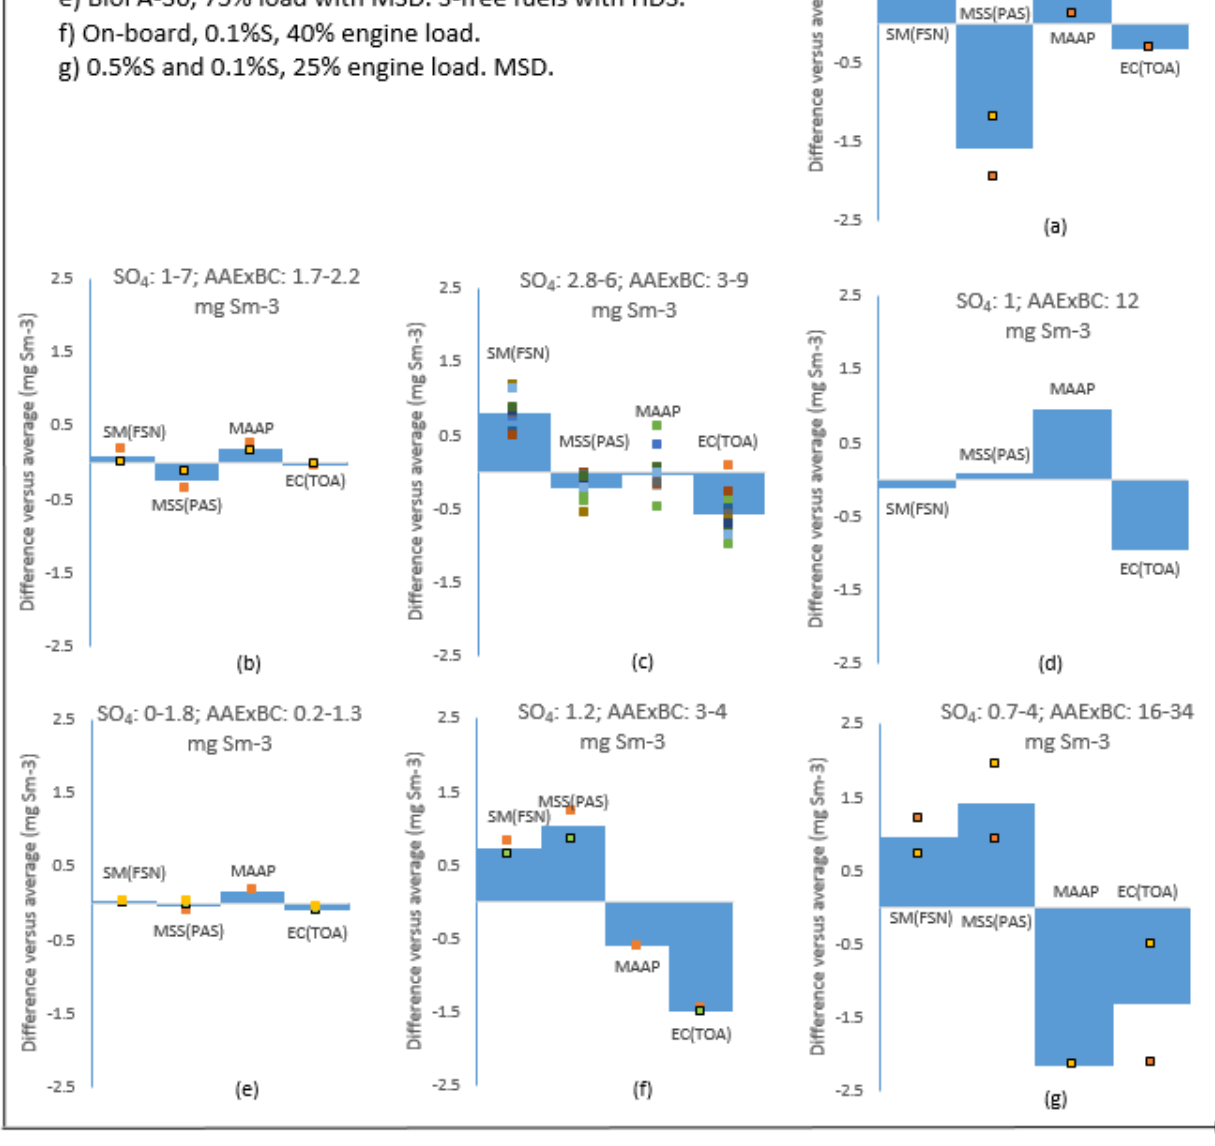
Figure 6. Measured Δ BC for exhaust concentrations of ( a ) high SO 42 − and high AAE 470/950 xBC; ( b – d ) medium SO 42 − and low, medium, and high AAE 470/950 xBC; and ( e – g ) low SO 42 − and low, medium, and high AAE 470/950 xBC. The square dots are data points, and bars are their averages.